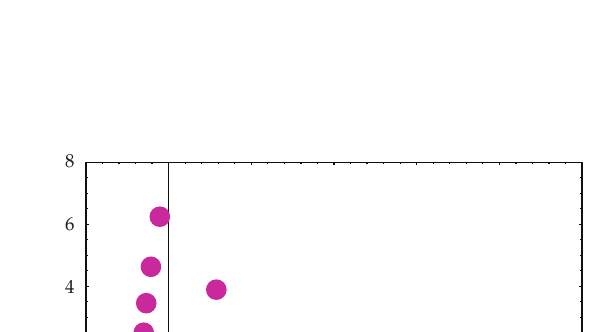
Figure 10: Zero of G 30 , 1 / 2 (cid:2) x (cid:3) .